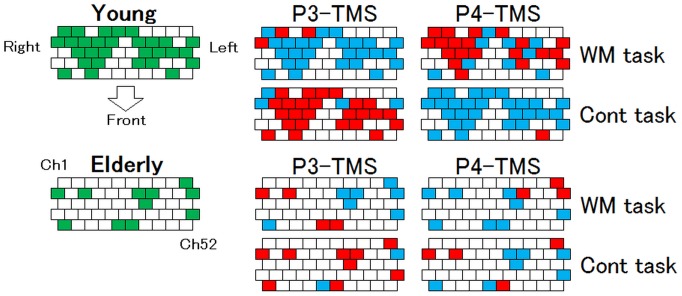
Distribution of significant P values mapped on the NIRS channels.The results of a three-way (Site × Task × TMS) ANOVA for oxy-Hb conducted for each of the 52 channels are show for both the young and the elderly participants. The channels for which the Site × Task × TMS interaction effect was significant are shown. The green channels indicate a location where the P value <0.05. The red channels indicate channels for which the oxy-Hb was increased, and the blue channels indicate channels for which the oxy-Hb was decreased.